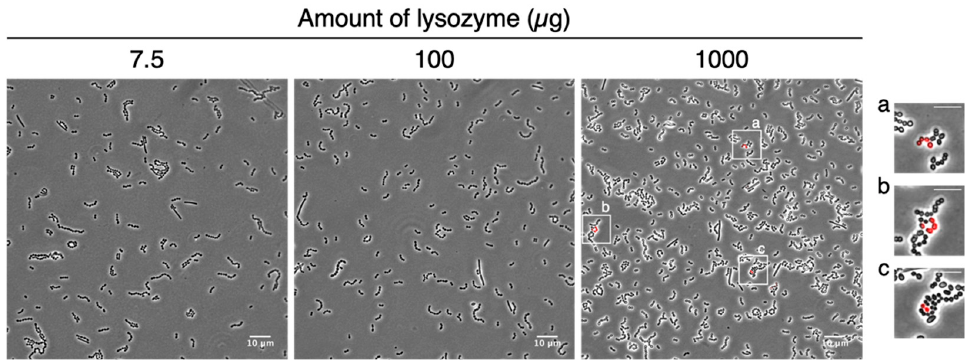
Figure 2. Determination of the lysozyme amount for S. thermophilus cell permeabilization. Large images show the detection of pflA mRNA using 3.5-h cultivated LAB cells permeabilized with 7.5, 100, or 1000 μ g of lysozyme. Images “a” to “c” are magnified images of S. thermophilus cells in which fluorescent signals were detected within LAB treated with 1000 μ g of lysozyme. Overlays of the phase contrast (grayscale) and Alexa568-labeled probes (red) targeting the RCA products from pflA mRNA are shown. Scale bars are 10 μ m in the large images and 5 μ m in the magnified images.